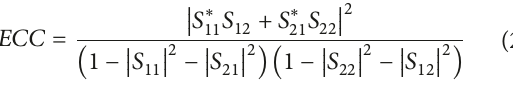
Simulator (HFSS) software is used. The simulation and measurement results are shown in Figure 5; Figure 5(a) shows impedance bandwidth with S 11 < − 10 dB from